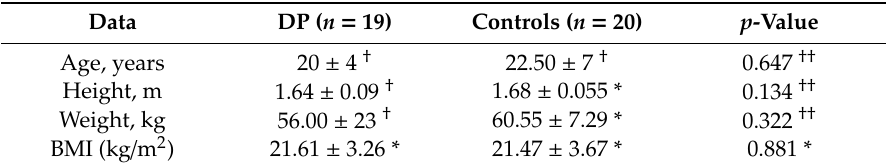
Table 1. Demographic data of the